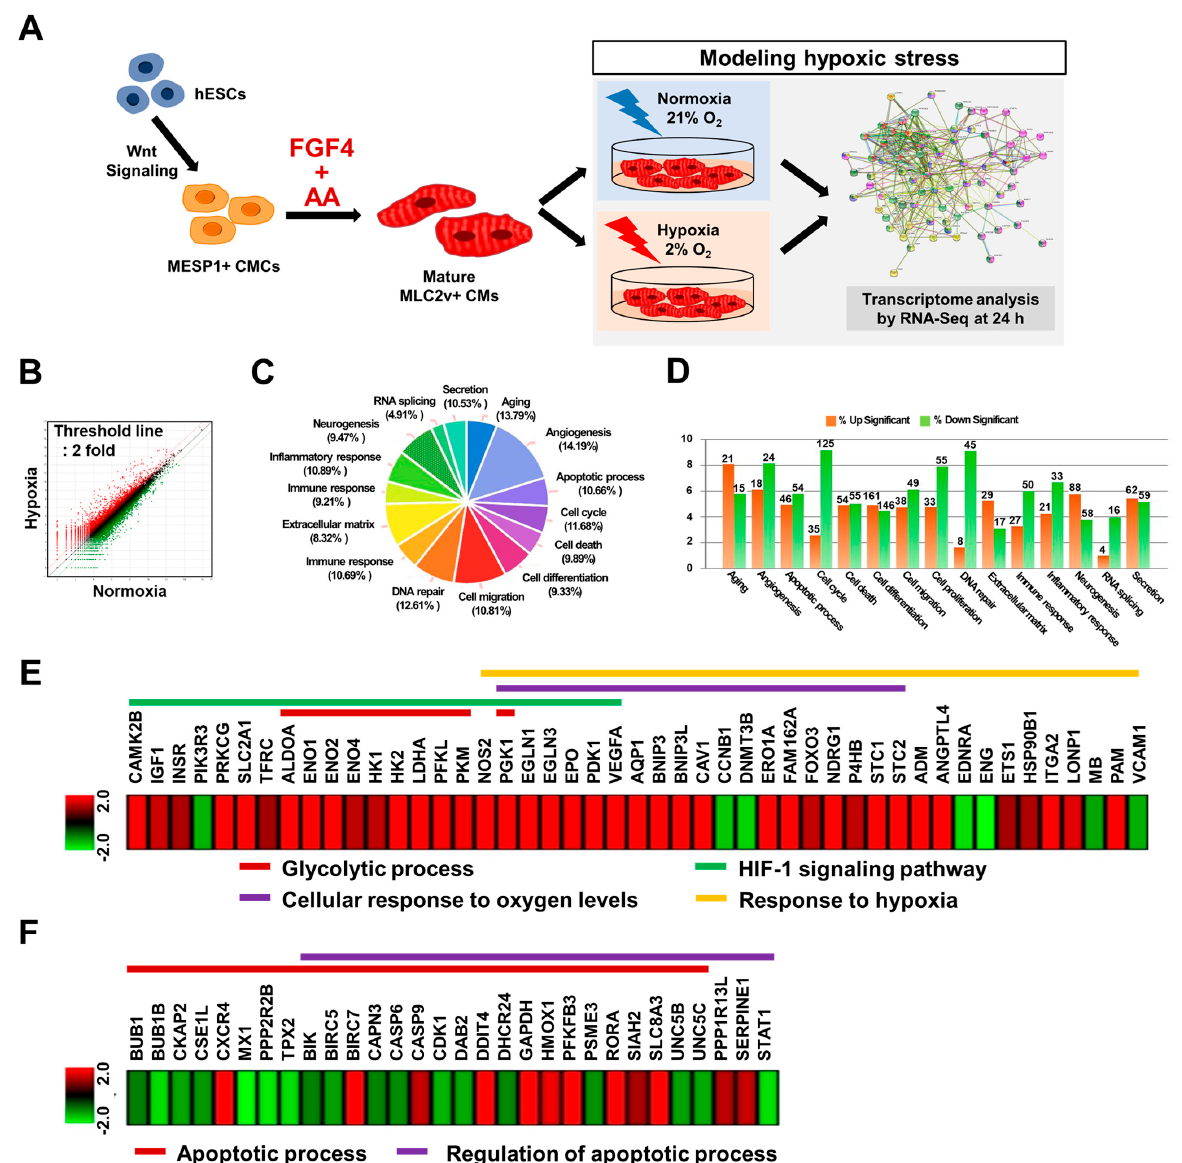
Figure 4. Transcriptome of FGF4+AA-treated BG01 hESC-CMs showing expression of hypoxia-responsive genes. ( A ) Schematic diagram of transcriptome analysis of FGF4+AA-treated hESC-CMs cultured under normoxic (21% O 2 ) or hypoxic (2% O 2 ) conditions for 24 h. CM: cardiomyocyte; CMC: cardiogenic mesoderm cell. ( B ) Scatter plot showing transcript expression in BG01 hESC-CMs cultured under normoxic- or hypoxic conditions for 24 h after treatment with FGF4+AA between days 5 and 15 of differentiation. ( C , D ) Gene ontology analysis of differentially expressed genes in hESC-CMs cultured under hypoxia for 24 h. Clustered heatmaps of differentially expressed genes related to ( E ) glycolytic process, HIF-signaling pathway, cellular response to oxygen levels, and response to hypoxia, and ( F ) apoptotic process, and regulation of apoptotic process in BG01 hESC-CMs cultured under hypoxia for 24 h (fold change 2; log2 normalized read counts of 4 were selected).